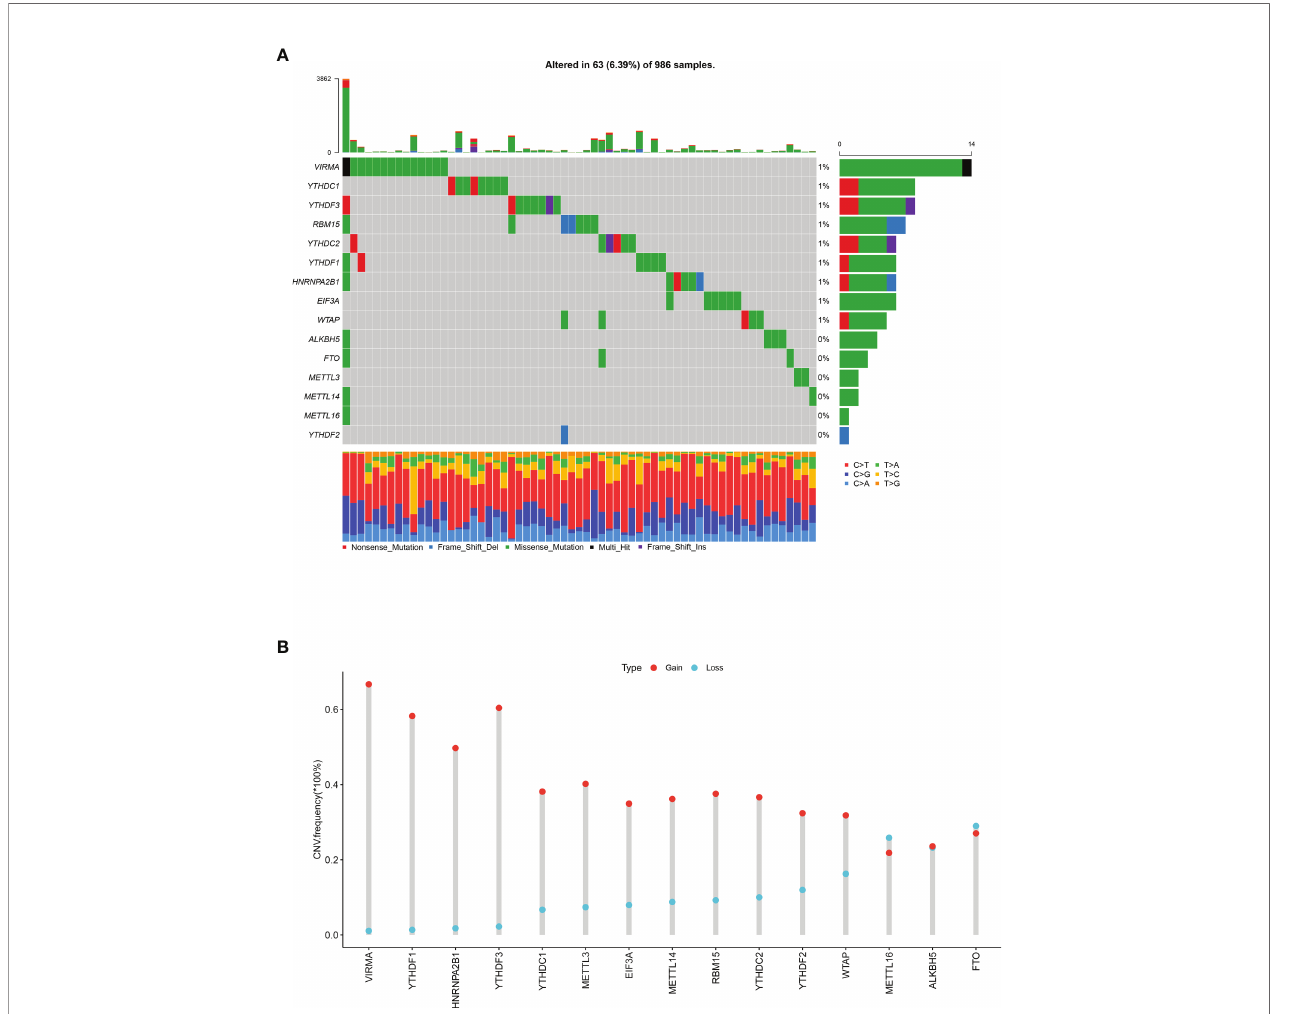
FIGURE 1 | Landscape of somatic mutations and CNVs of 15 m 6 A regulators in breast cancer. (A) The waterfall plot of tumor somatic mutations of 15 m 6 A regulators in 986 breast cancer patients. Each column represented a sample or patient, and mutation rates in the tumor samples were shown in the top barplot. The number on the right indicated the mutation frequency of each regulator, and the right barplot showed the proportion of each variant type. The bottom barplot represented the proportion of each base mutation in each sample. (B) The CNVs frequency of 15 m 6 A regulators in 1,067 breast cancer samples. The height of the column represented the variation frequency. The blue dot was deletion frequency; the red dot was ampli fi cation